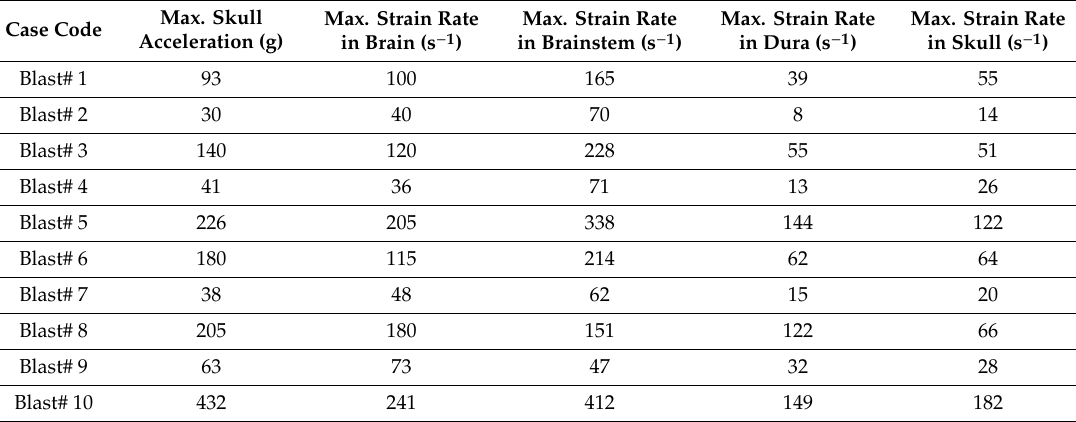
Table 7. The predicted maximum linear acceleration of skull, and strain rate of the brain, brainstem, skull, and dura at di ff erent blast